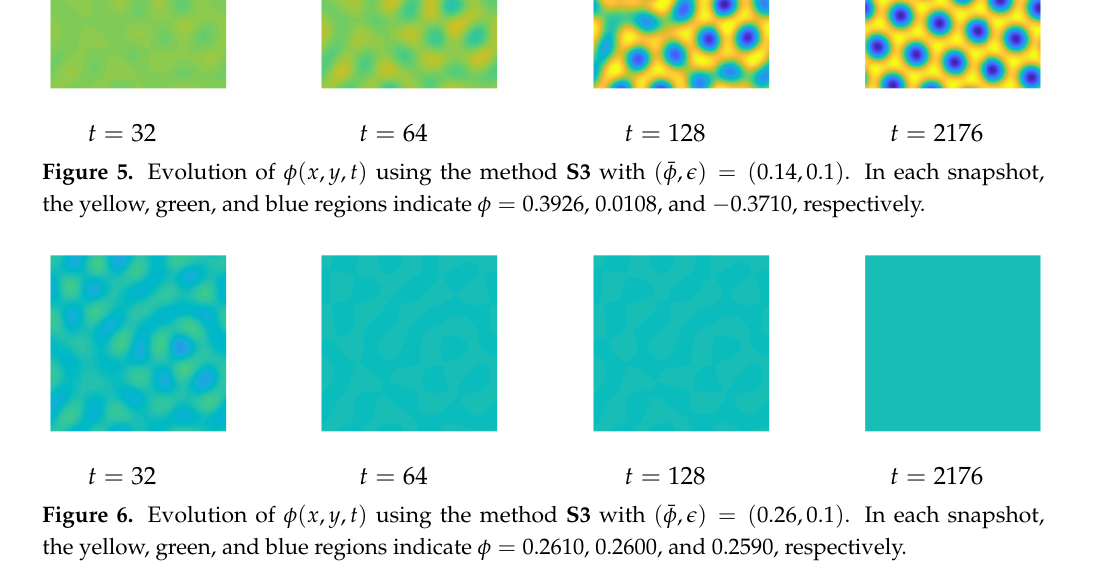
Figure 6. Evolution of φ ( x , y , t ) using the method S3 with ( ¯ φ , (cid:101) ) = ( 0.26,0.1 ) . In each snapshot, the yellow, green, and blue regions indicate φ = 0.2610, 0.2600, and 0.2590, respectively.